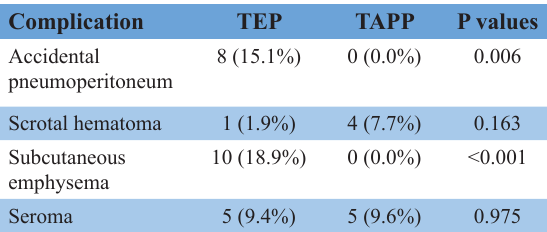
Table 5. Complications in TAPP and TEP Complication TEP TAPP P values pneumoperitoneum